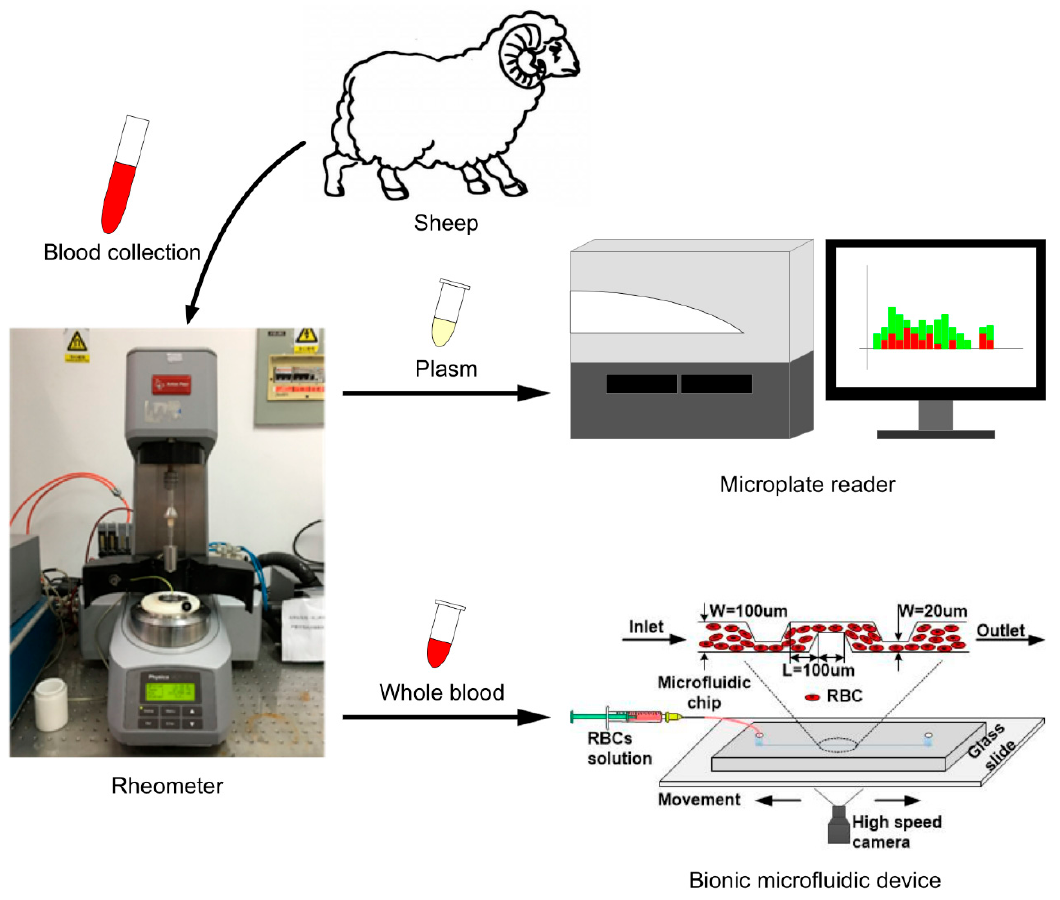
Figure 1. Schematics of the impact of erythrocytes injury caused by mechanical shear stress force on flow patterns in bionic arteriole with stenosis segment. flow patterns in bionic arteriole with stenosis